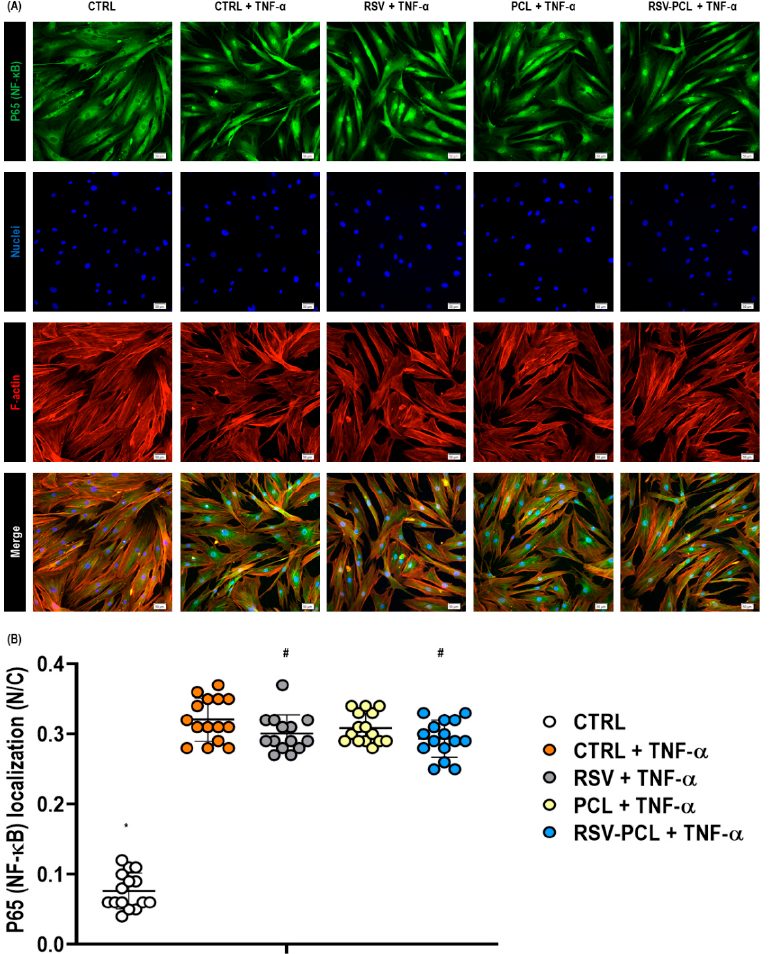
Figure 8. Effect of 0% RSV-PCL (PCL) and 10% RSV-PCL (RSV-PCL) electrosprayed microparticles on the NF- κ B signaling pathway. Immunocytochemistry ( A ) and complementary relative fluorescence intensity ( B ) analysis of the NF- κ B subunit p65 localization illustrated that TNF- α stimulation (50 ng/mL) induced significant ( p < 0.05) nuclear translocation of p65 (indicative of NF- κ B activation) after 24 h ( n = 3. p65: green, F-actin: red, Nuclei: blue. Scale bars: 50 μ m). The 10% RSV-PCL microparticles did not robustly prevent or reverse nuclear translocation of the NF- κ B subunit p65, even though a minor effect was noted ( p < 0.05). * indicates a statistically significant difference between all groups ( p < 0.05). # indicates statistically significant to CTRL + TNF- α group ( p < 0.05). Individual values ( n = 15 images per group) are displayed as dots on bar charts. Error bars represent mean ± SD. Generalized linear models and bootstrap- t -tests. 4. Discussion Given the complex etiology of chronic wounds, RSV represents a multifunctional therapeutic capable of tackling numerous aspects of the wound microenvironment, especially the uncontrolled and self-sustaining inflammatory, proteolytic, and oxidative